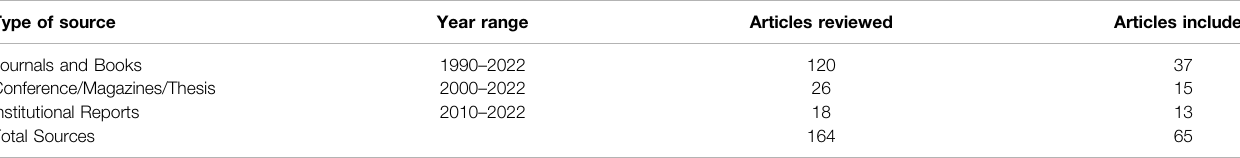
TABLE 1 | Total type and number of